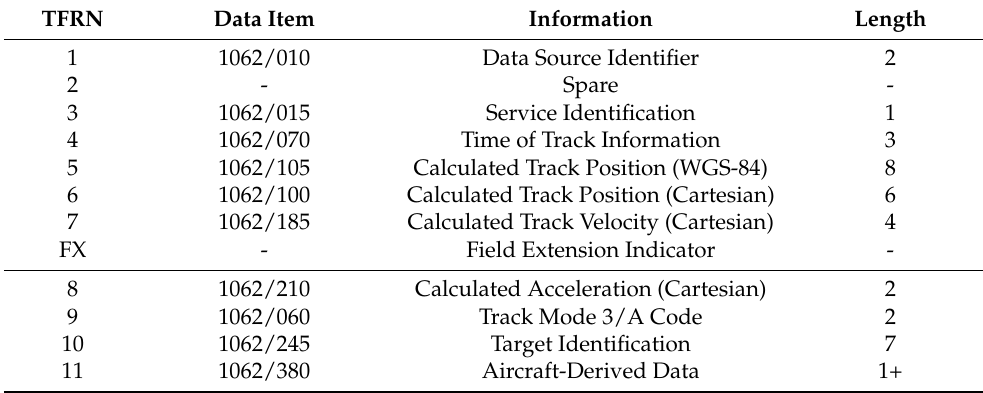
Table 1. Overview of the cat-062 text